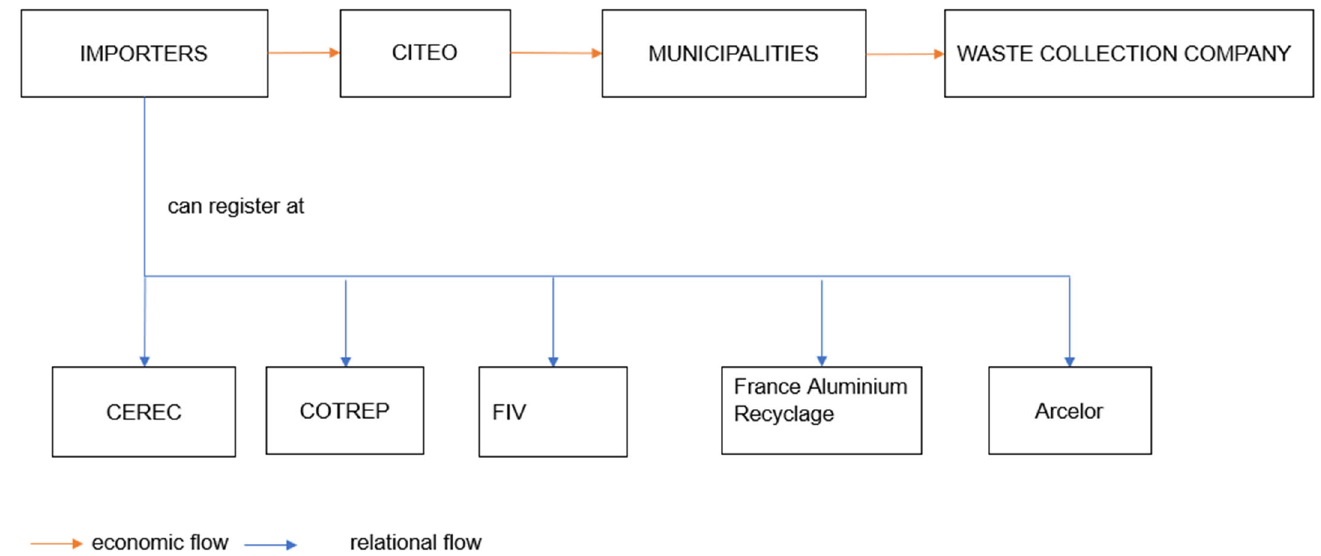
Figure 2. French packaging waste management model. Source: own elaboration based on [28,29]. Table 2. Responsibilities for prevention, collection, recycling, and recovery in France.